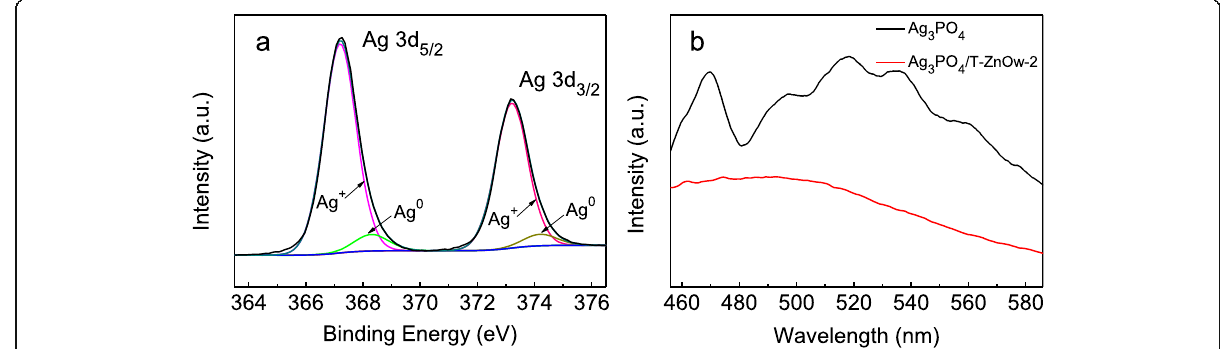
Fig. 9 a Ag 3d XPS spectrum of Ag 3 PO 4 /T-ZnOw-2 sample after photocatalysis. b PL spectra of Ag 3 PO 4 and Ag 3 PO 4